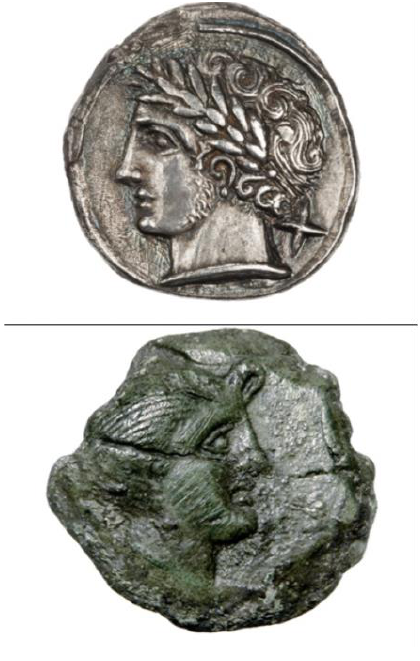
Figure 4. Training Dataset, Coin